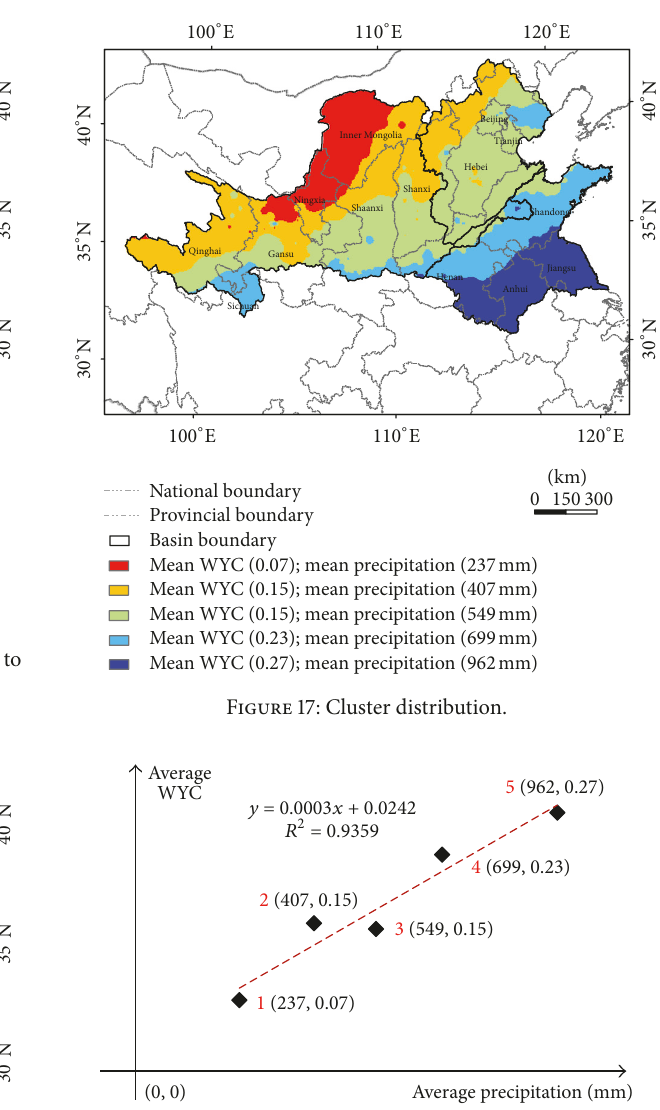
Figure 18: The coupled relationship between average WYC and precipitation from 1961 to